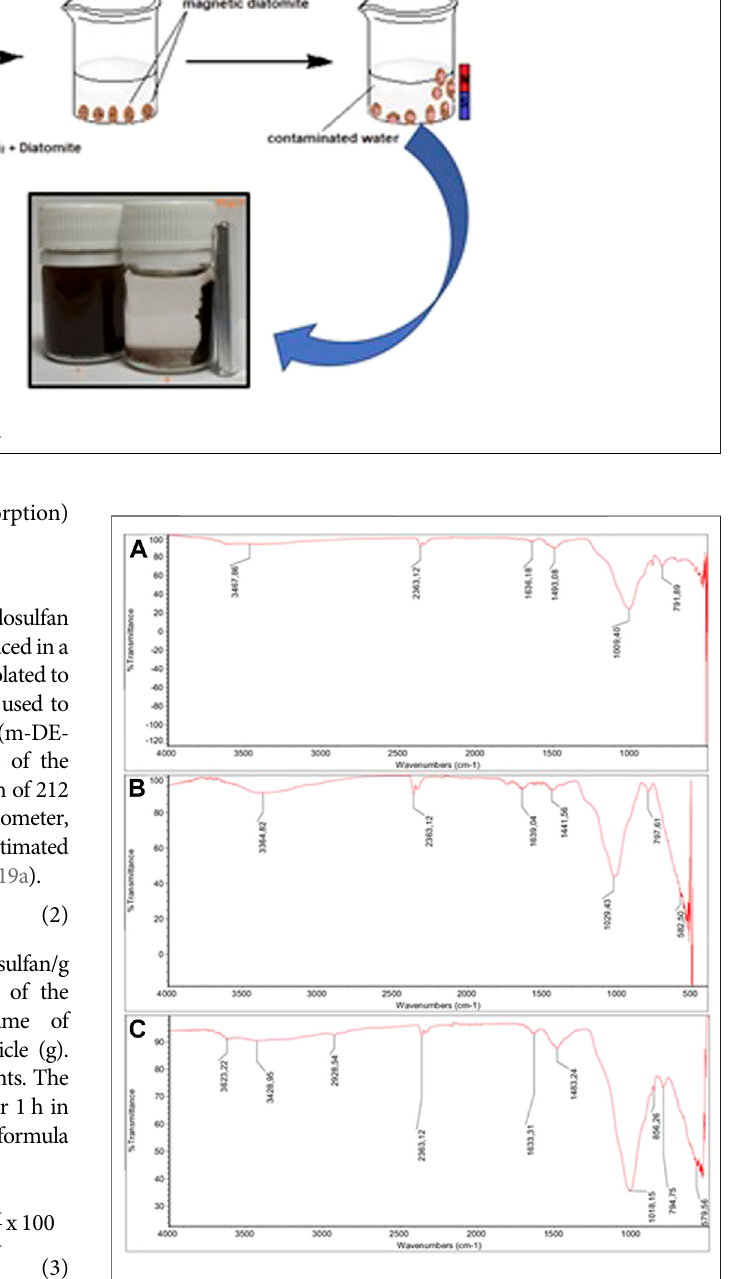
FIGURE 2 | (A) FTIR spectrums of DE, (B) FTIR spectrums of m-DE, (C) FTIR spectrums of